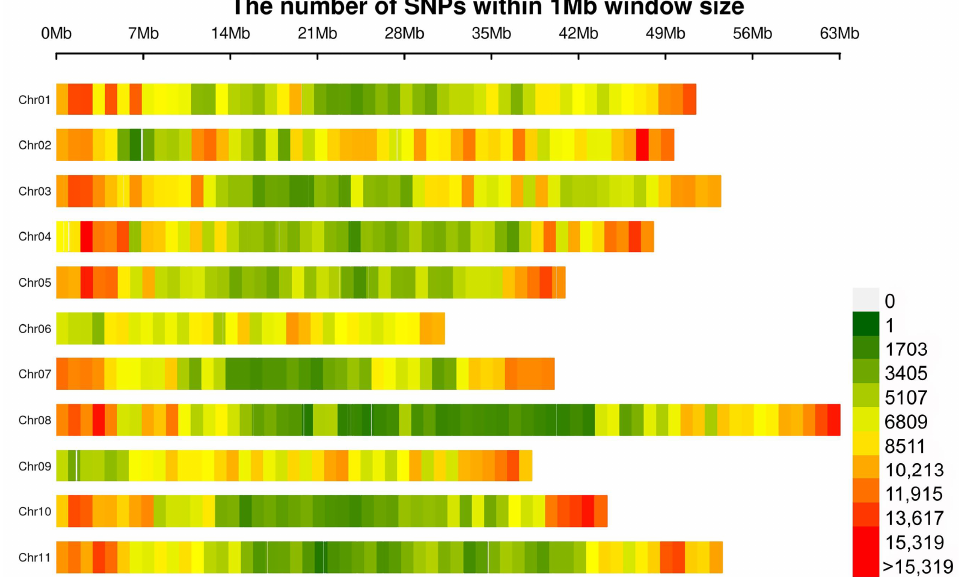
Figure 2. The number of SNPs within a 1 Mb window size across common bean chromosomes.